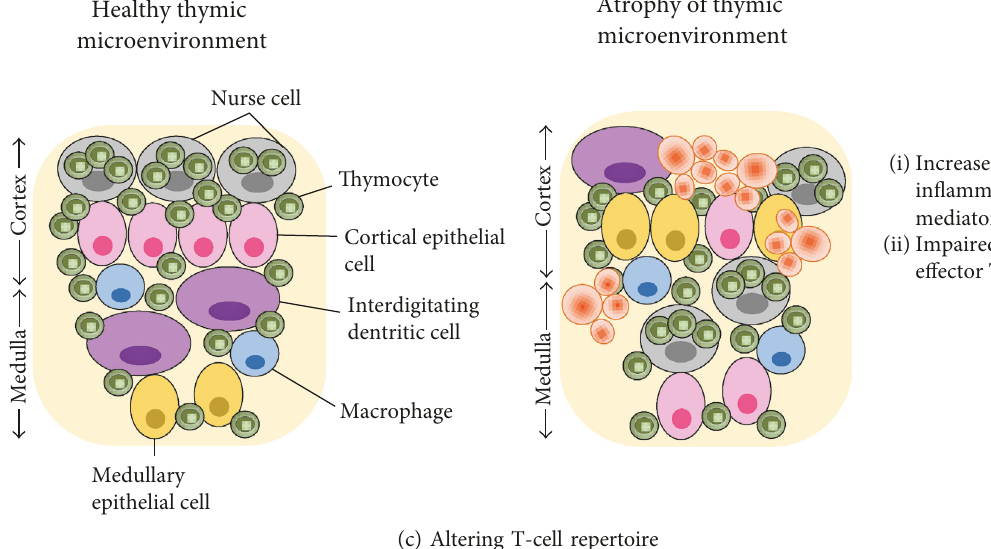
Figure 2: Diagram of proposed Paracoccidioides spp. immune-evasion mechanisms. (a) Shielding of stimulatory PAMPs. The cell wall beta-glucan present in the fungus saprophytic forms (conidia and mycelia) is recognized by the macrophage Dectin-1 receptor; however, pathogenic yeast cell α -(1,3)-glucan masks β -(1,3)-glucan, avoiding its recognition. (b) Intracellular survival. Paracoccidiodes spp. use several strategies to overcome the host harsh environment, among them are the following: (1) promoting invasion to the pulmonary epithelial cells by altering their cytoskeleton structure, a process assisted by gp43; (2) avoiding phagocytosis by displaying an enlarged multibudding morphology, boosted by Cdc42 expression, which physically impairs engulfment by macrophages; and (3) adapting to the host environment. The phagocytosed fungus shifts its metabolism to tolerate macrophage stress conditions and even modulate host apoptosis enabling fungal killing. (c) Altering T-cell repertoire. During acute fungal infections, yeast cells invade the thymus altering its epithelial cells ’ spatial arrangement crucial for T-cell di ff erentiation and pathogen-speci fi c immune